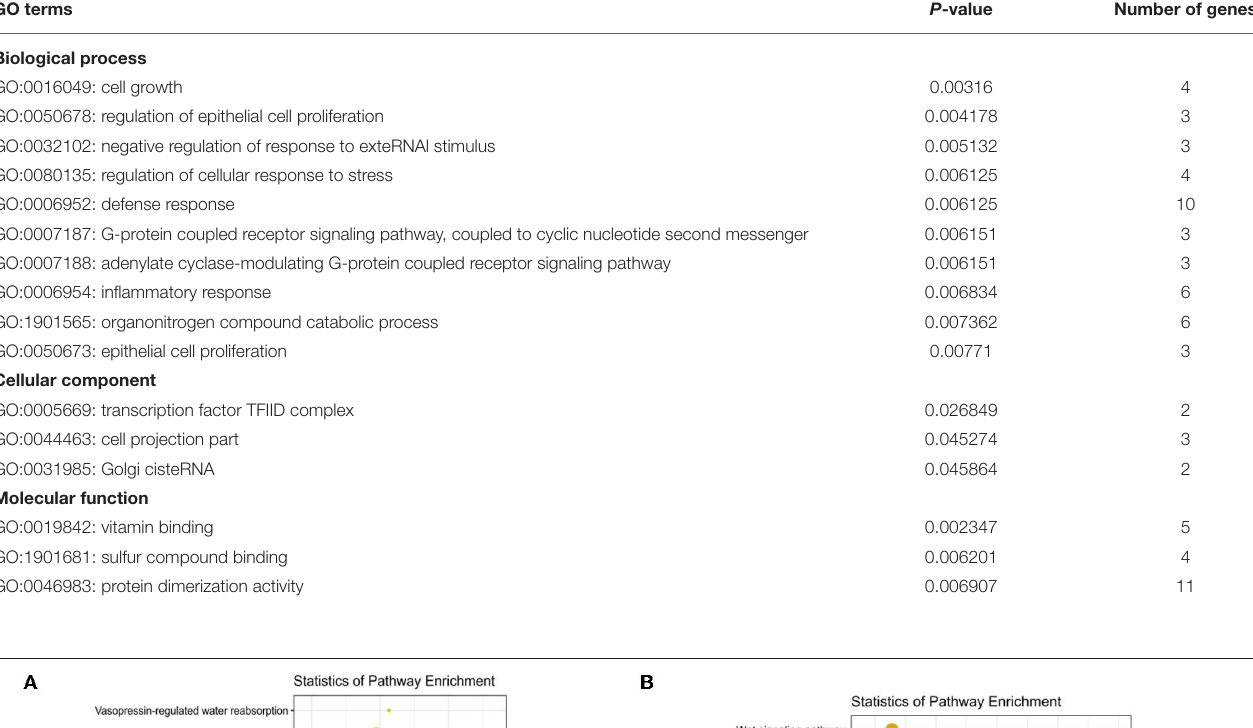
TABLE 3 | Biological process enriched by the differentially expressed mRNAs in M120 vs. M90 group. GO terms P -value Number of genes Biological process